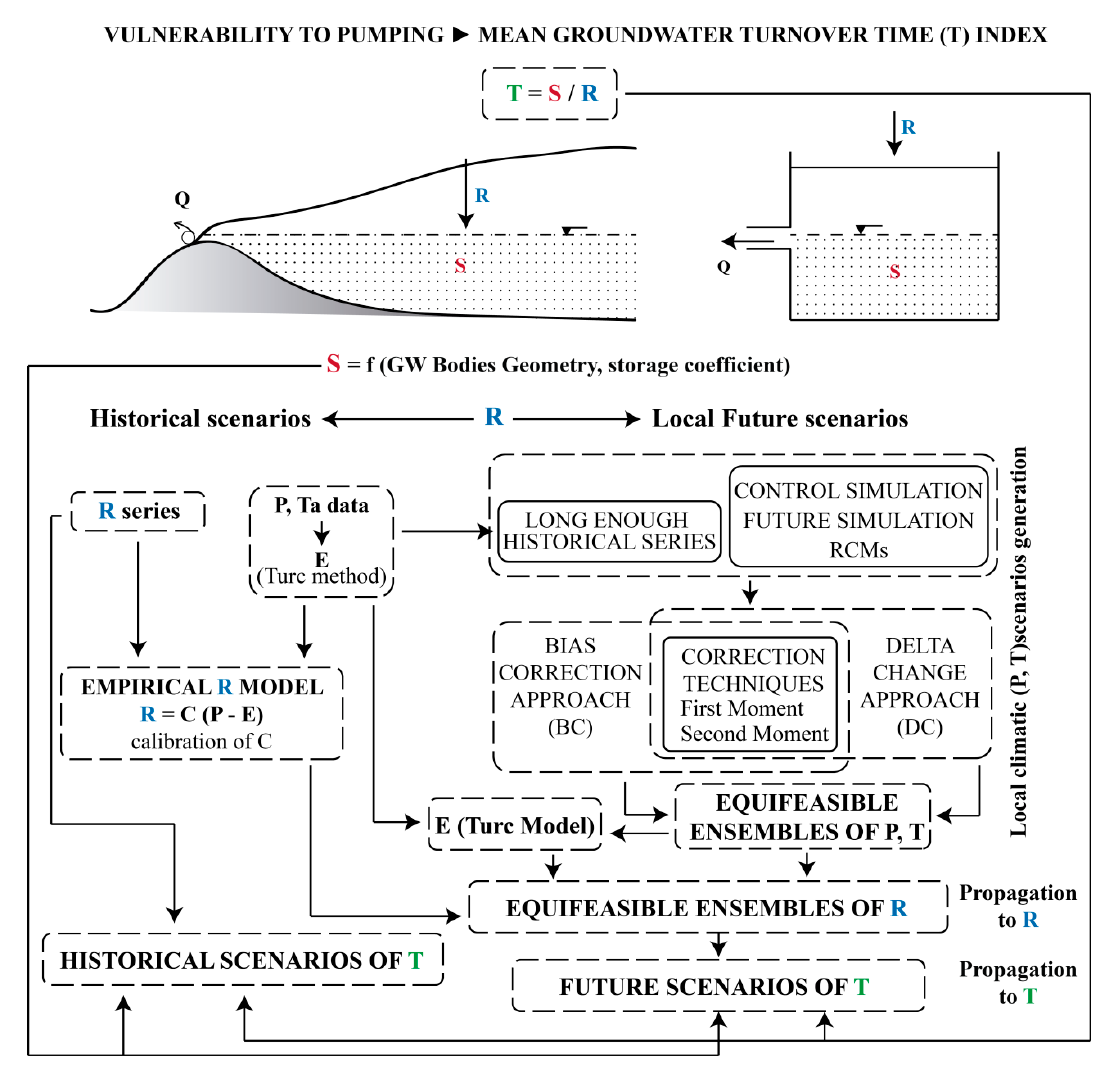
Figure 1. Flowchart of the methodology developed to assess groundwater (GW) bodies’ vulnerability to pumping. Notation and units for variables used: P, E, R, and Q are respectively precipitation, actual evapotranspiration, net GW recharge from P, and net GW discharge in mm year − 1 ; Ta is temperature in °C; C and S are respectively a dimensionless effective recharge coefficient ( − ) and a GW storage (Mm 3 ); and T is the natural turnover time index in years.